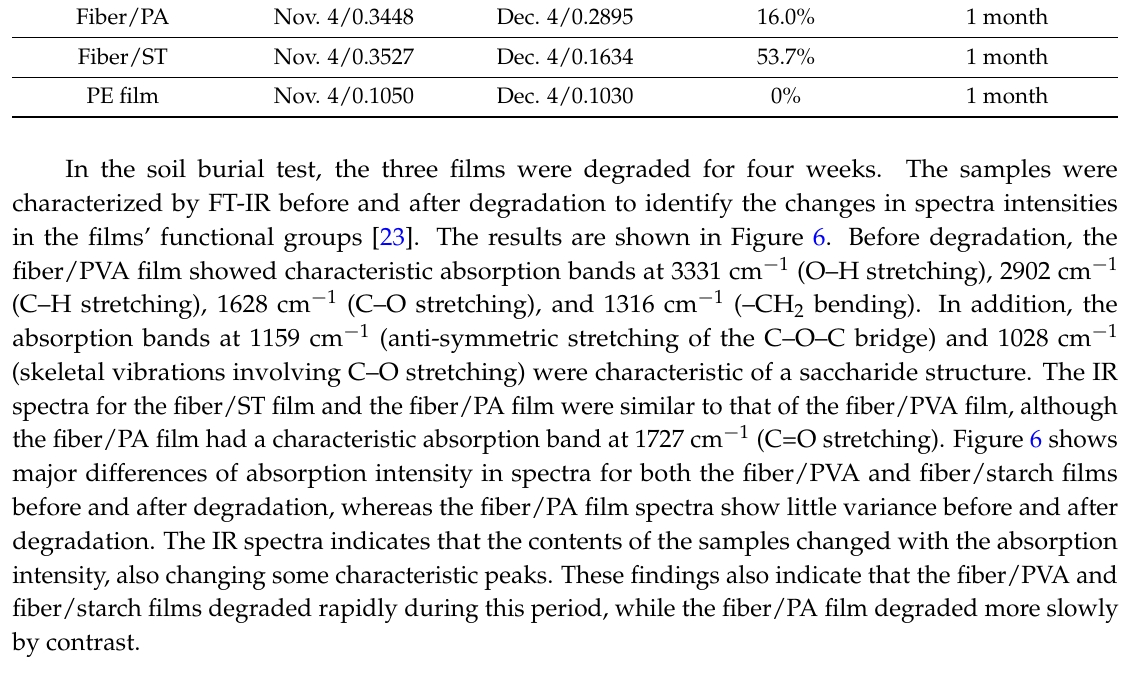
Table 2. The weight loss of fiber/polymer films after different degradation time by soil burial test.